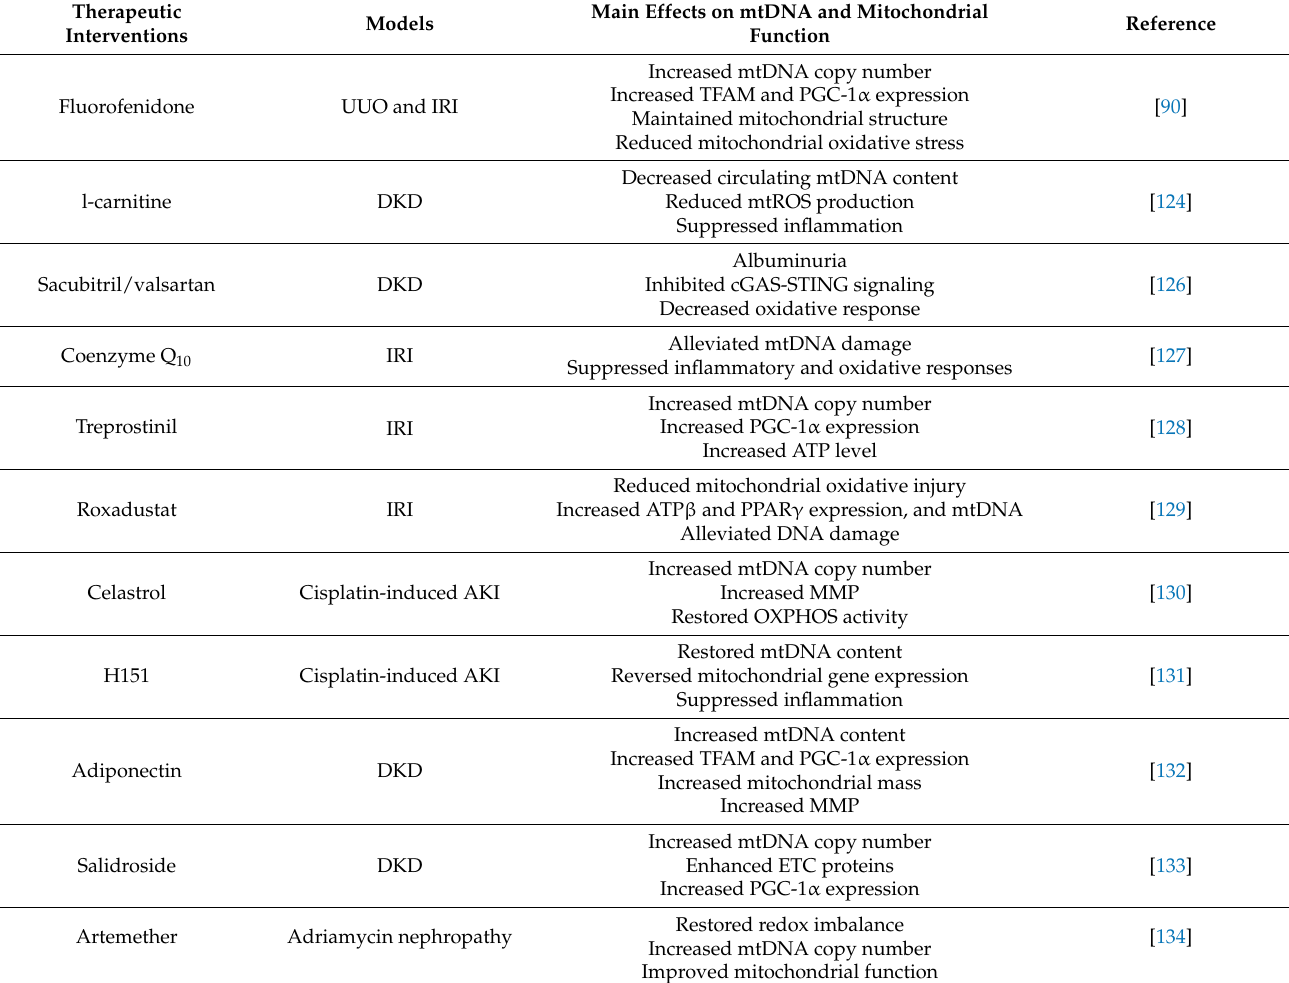
Table 2. Therapeutic intervention for mtDNA in different kidney